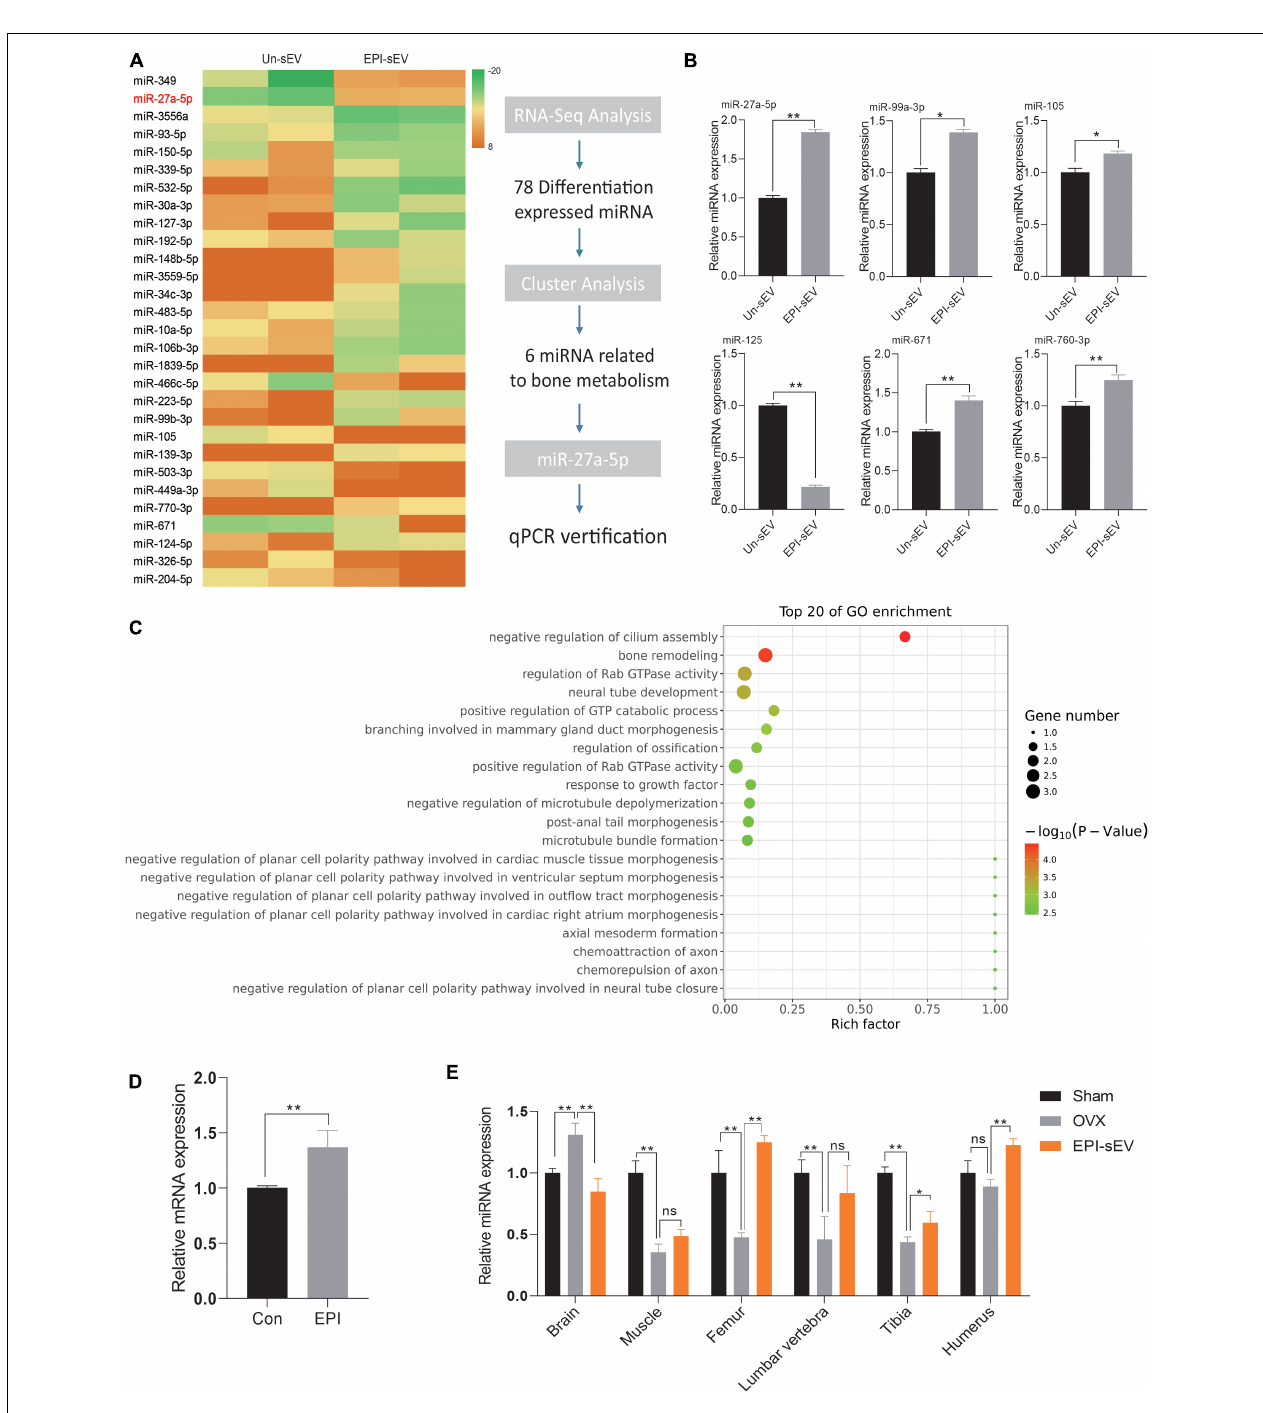
FIGURE 5 | Specific miRNA profiles enriched in EPI-sEV. (A) The unique enrichment of a set of miRNAs in EPI-sEV compared with the control group. (B) Verification of six miRNAs; the normalized data represented mean ± SD. (C) Pathway analysis of the top 20 miRNAs. (D) Expression of miR-27-5p expression with or without EPI treatment in BMSCs; the normalized data represented mean ± SD. (E) miR-27a-5p expression in different tissues; the normalized data represented mean ± SD. * p < 0.05, ** p < 0.01; ns, non-significant; analyses were performed twice and obtained comparable